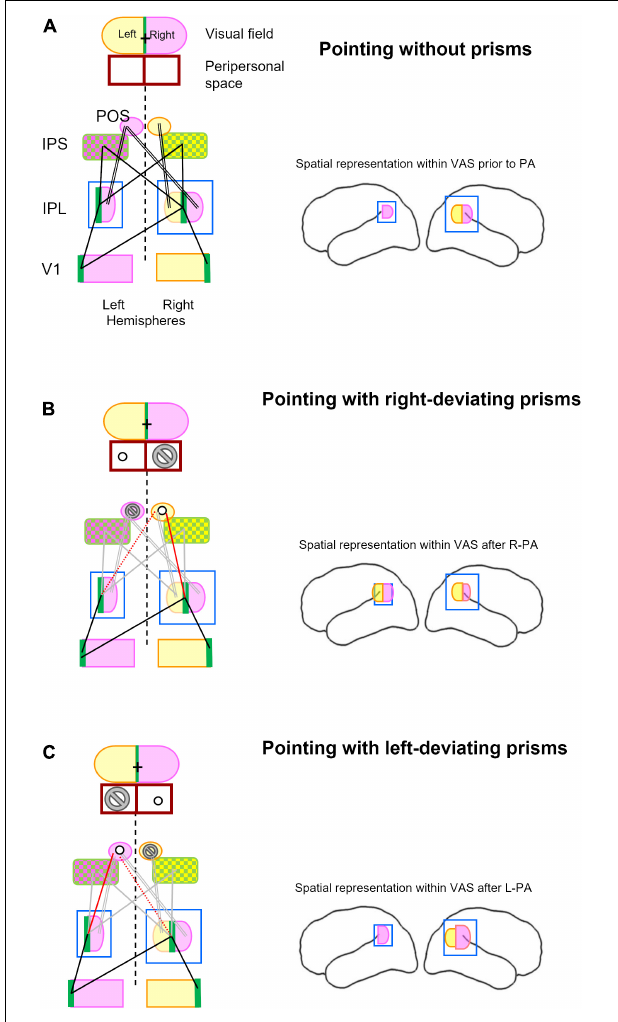
FIGURE 3 | Schematic representation of key structures involved in visual pointing and their topographical relationship while pointing without prism (A) , with right-deviating prisms (B) , and with left-deviating prisms (C) . Lateral views of the left and right hemispheres in right-hand column summarize spatial representation within the inferior parietal lobule and its changes after prismatic adaptation as described previously (Crottaz-Herbette et al., 2014, 2017b; Tissieres et al., 2018). (A) The visual field is subdivided into right (violet), left (yellow), and vertical meridian parts (green). Left and right halves of peripersonal space are outlined below the visual field figurine and are aligned with it, representing thus the situation of pointing to central (visual) targets. The same color code, violet for right, yellow for left, and green for central visual field, is used for the respective representations within the primary visual area (V1), the inferior parietal lobule (IPL), the intraparietal sulcus (IPS), and the parieto-occipital sulcus (POS). For simplicity reason, the extra-striate visual areas are not included. Whereas IPS encodes central (green) and contralateral targets (violet and yellow, respectively), POS encodes only the contralateral targets. Pointing to visual targets at (central) fixation is the most accurate (Prado et al., 2005) and most commonly adopted. Without prisms, pointing to central target involved central visual field representations (green) in visual areas (here represented by V1), IPL and IPS. Main topographic relationships involved in pointing to central targets are indicated here by single black lines, those involved in pointing to peripheral targets by double black lines. Brain figurine on the right depicts bilateral space representation in right IPL. (Continued)